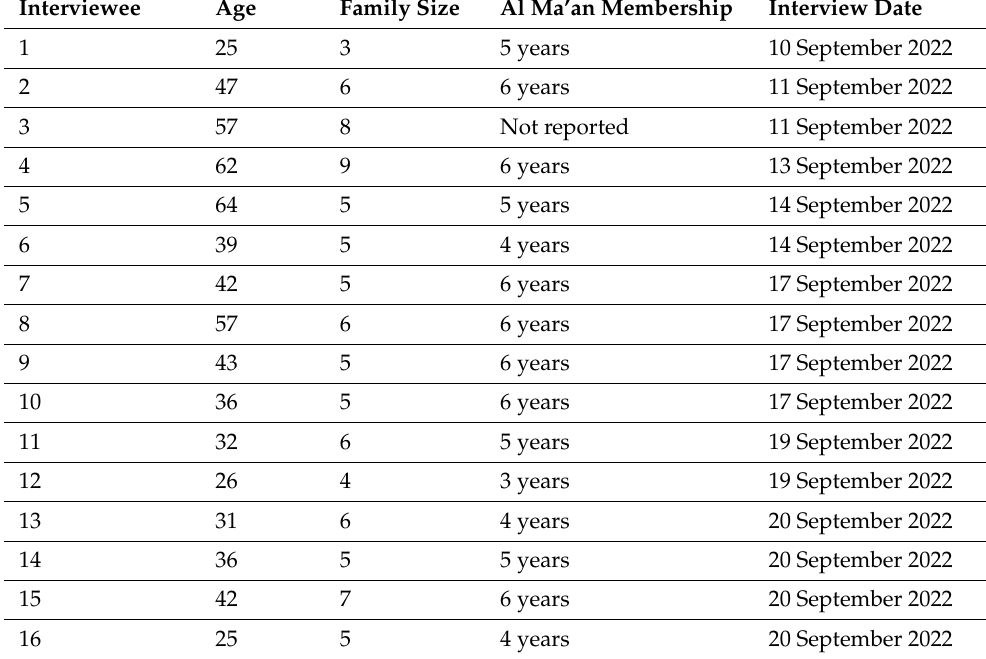
Table 1. Interviewees’